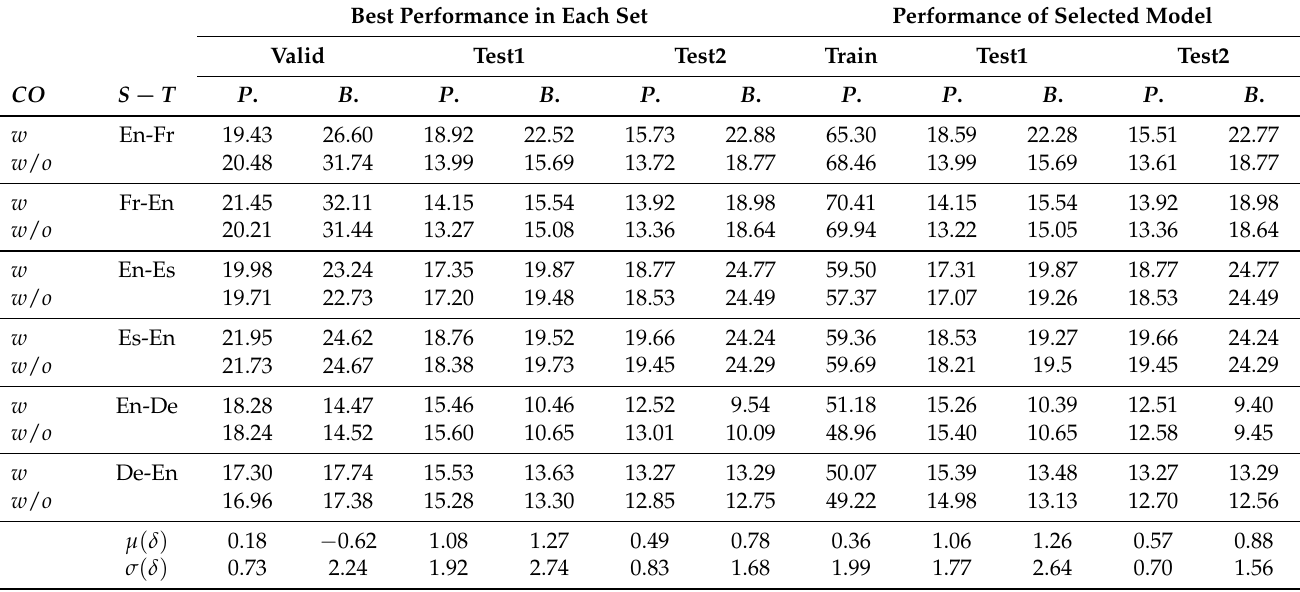
Table 8. Performance change by using Cost-Out in